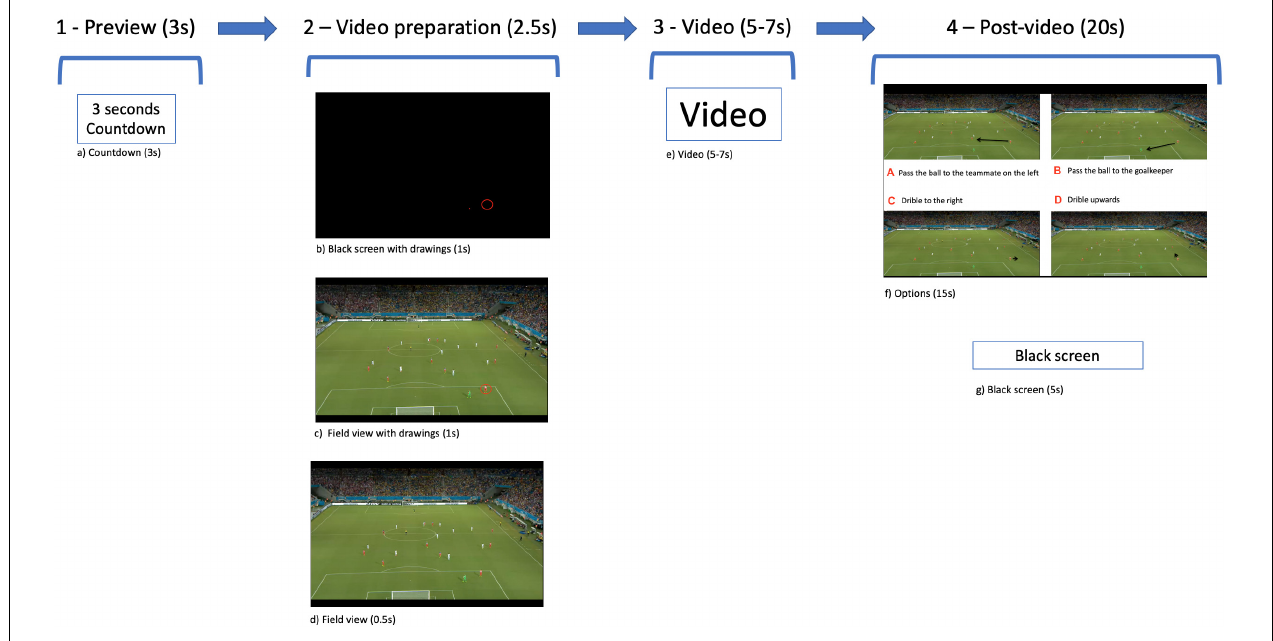
FIGURE 2 | Order of presentation of the